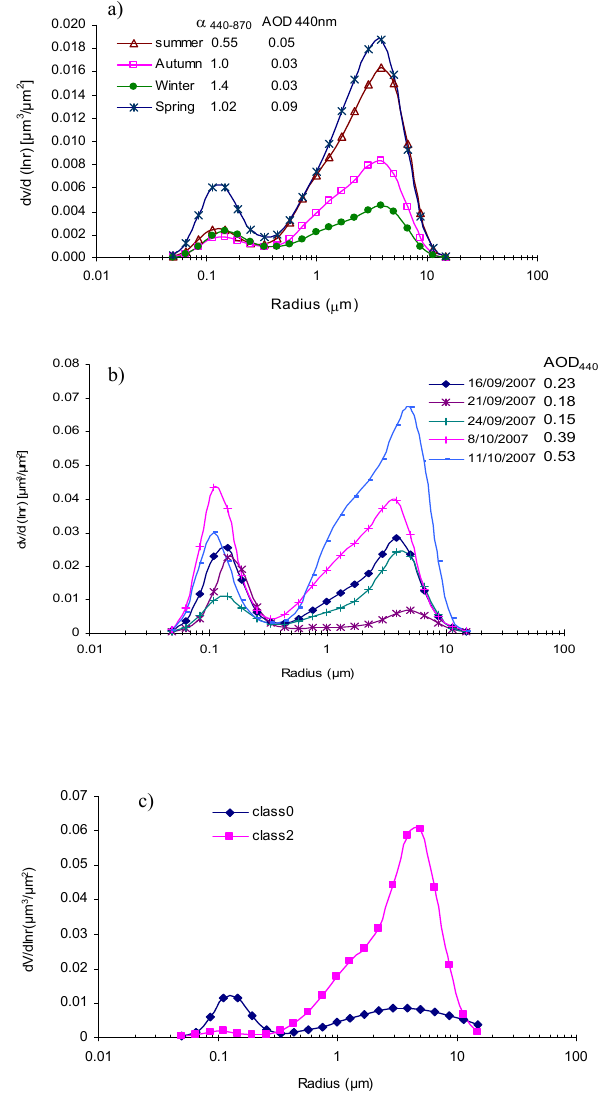
Fig. 6. (a) Seasonal average volume size distributions. (b) Daily average volume size distributions for selected days. (c) Qin and Mitchell (2009) class 0 and class 2 size distributions.